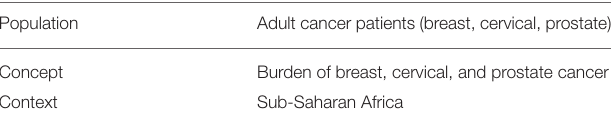
TABLE 1 | PCC framework used to determine the eligibility of the research question and to guide the selection of studies on the burden of breast, cervical and prostate